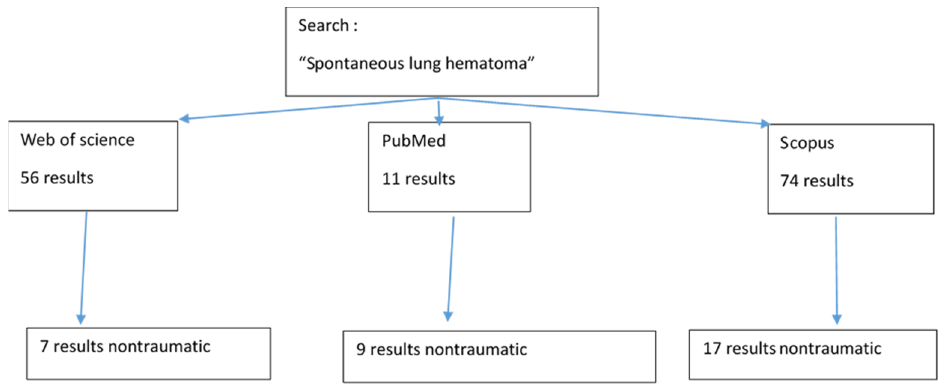
Figure 5. Literature research of “spontaneous lung hematoma” scheme .